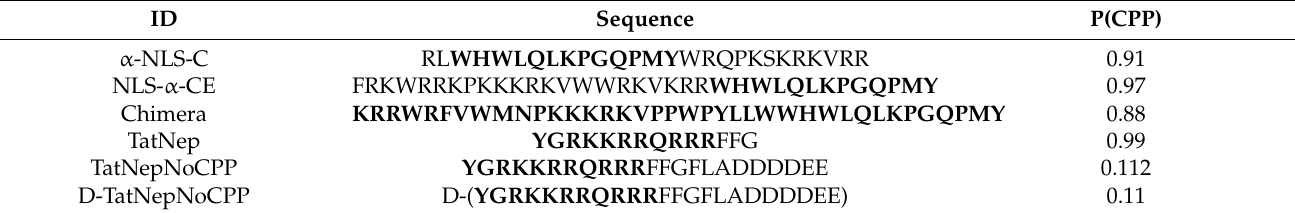
Table 1. Moonlighting CPP sequences used in this